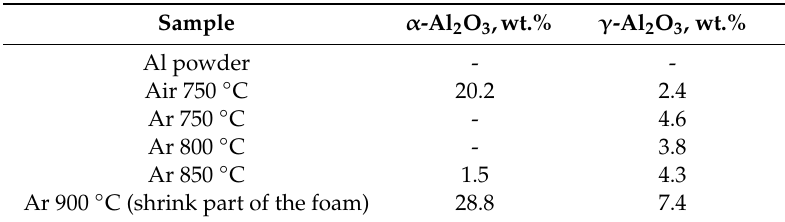
Table 2. Phase composition of the as-received powder and the aluminum foams thermally processed for 3 h at 750 ◦ C in air and at 750–900 ◦ C in